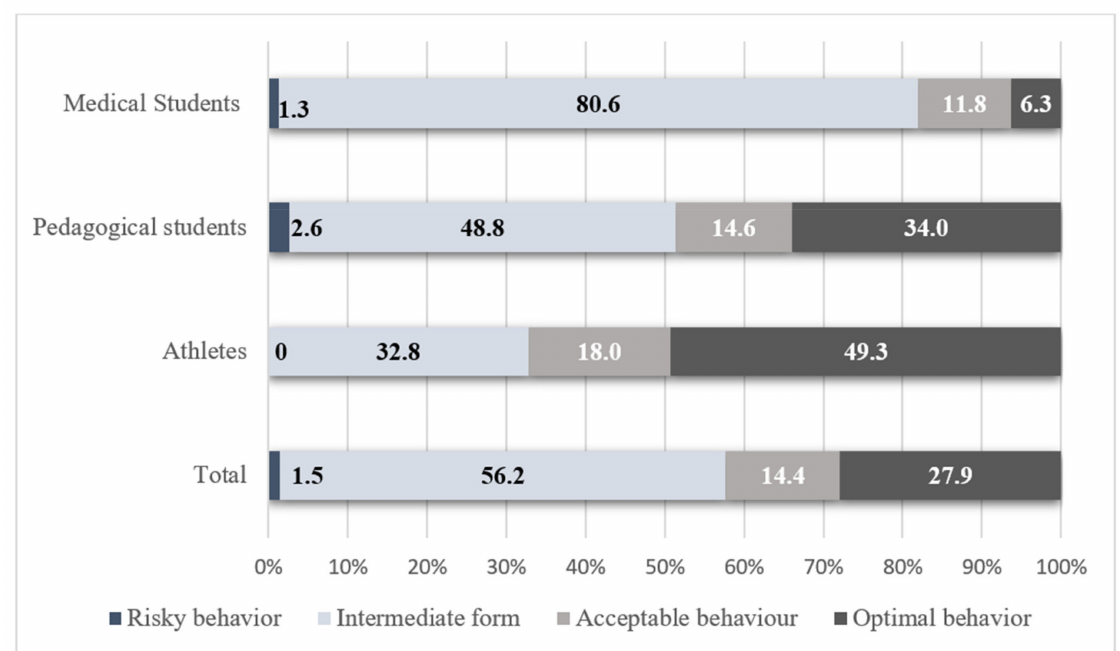
Figure 3. Share of behavior patterns depending on the group of the